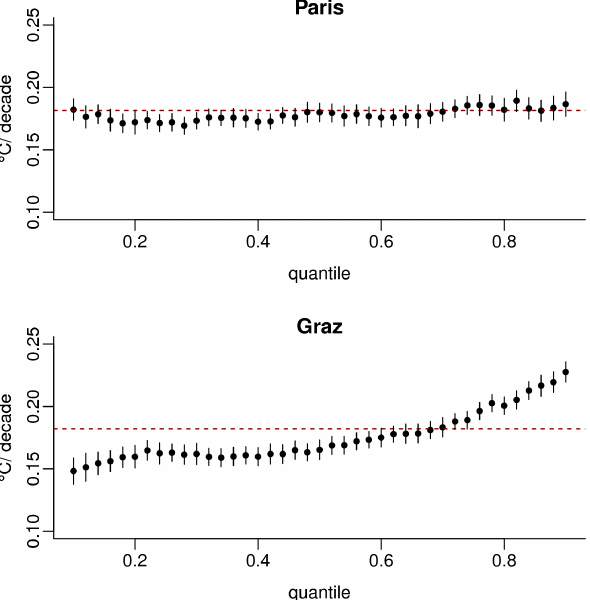
Fig. 3. Quantile slopes ( ◦ Cdecade − 1 ) and corresponding standard errors for Paris and Graz records. The horizontal dashed line repre- sents the usual ordinary least squares slope.